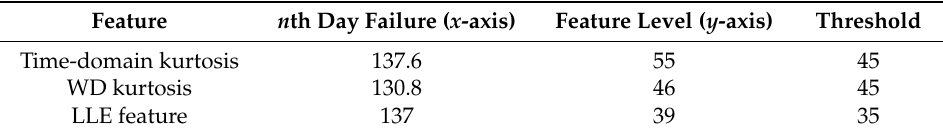
Table 9. Original non-linear data points and predicted data points of time domain kurtosis.